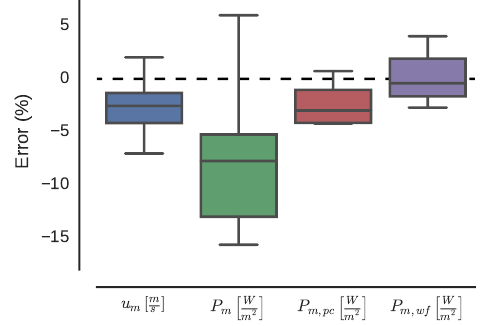
Figure 12. Distribution of errors from the model’s output at 90m at FINO3 for the following errors: (1) the mean wind speed u m (blue), (2) the power density P m (green), (3) the power density with an implied power curve P m , pc (red), and (4) the averaged power density of a wind farm, including the same implied power curve as (3) and the wake effects (purple). Outliers are not shown; the most extreme ones are − 25% for u m , − 60% for P m , − 37% for P m , wf , and − 35% for P m ,